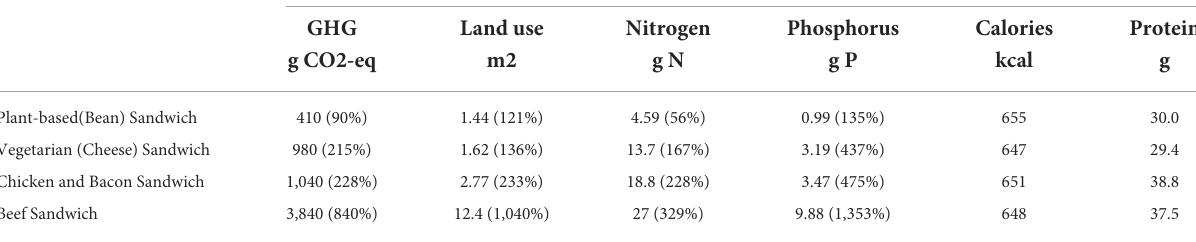
TABLE 2 Single-meal footprint calculations, caloric levels, and